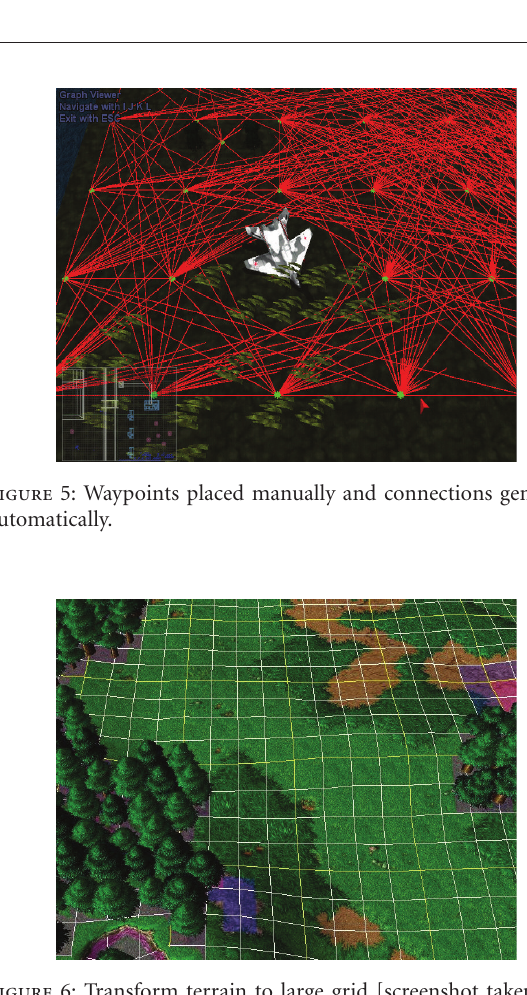
Figure 6: Transform terrain to large grid [screenshot taken from Warcraft III map editor].